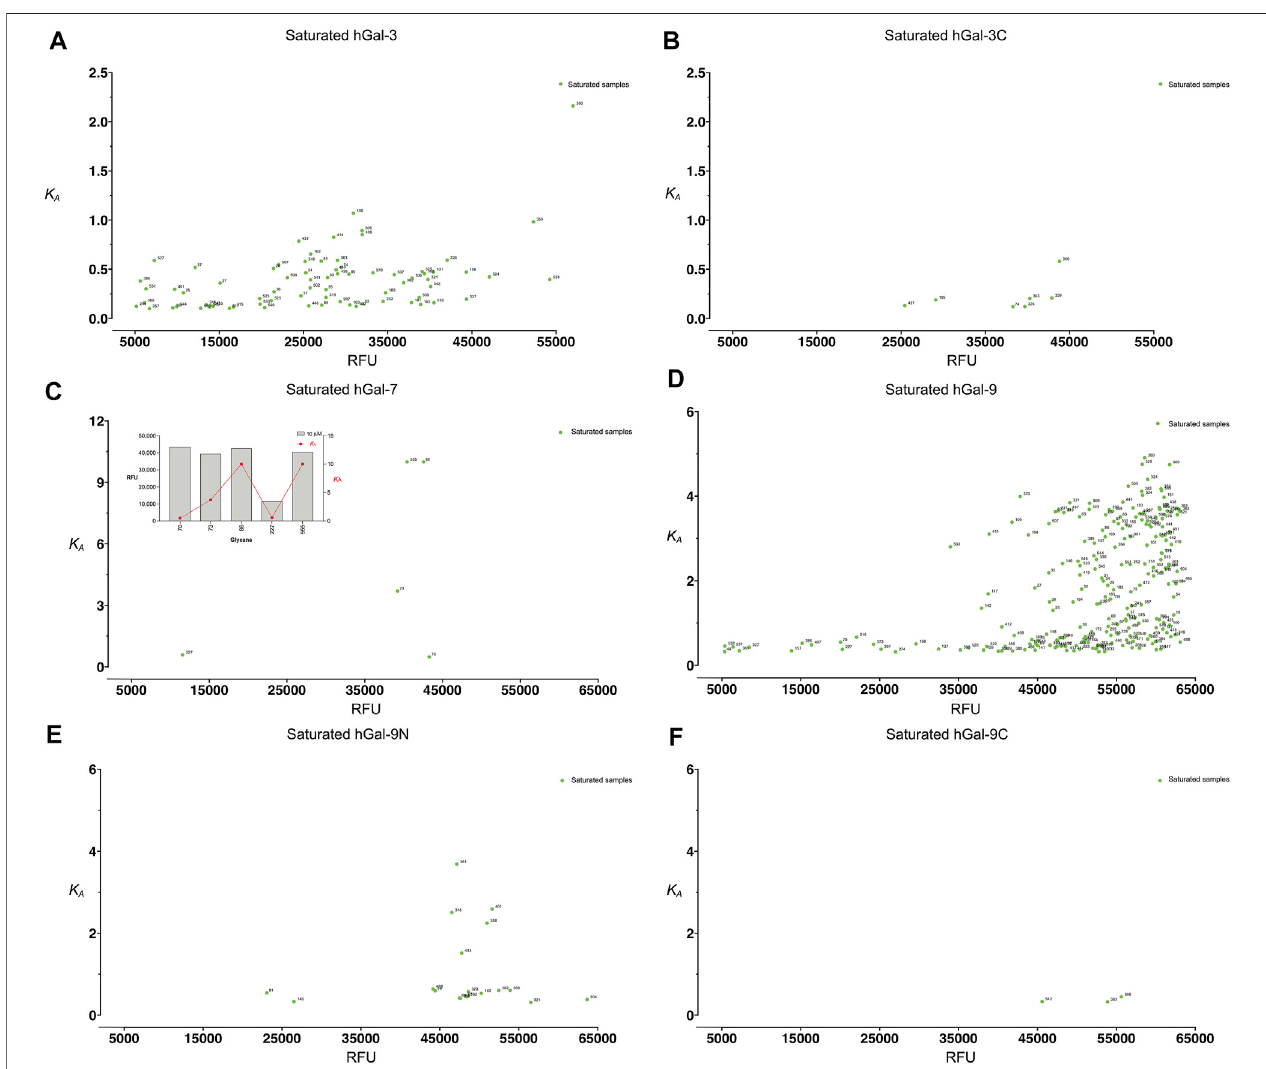
FIGURE 3 | Examination of the distribution of saturated glycans for each galectin . (A) The saturated samples ’ RFU values are plotted against K A for Gal-3. (B) The saturatedsamples ’ RFUvaluesareplottedagainst K A forGal-3C (C) Thesaturatedsamples ’ RFUvaluesareplottedagainst K A forGal-7.Abarplotispresentedwiththe fi ve saturated samples along with their K ’ RFU values are plotted against K A and RFU values shown on the upper left. (D) The saturated samples A for Gal-9 (E) The saturated samples ’ RFU values are plotted against K A for Gal-9N. (F) The saturated samples ’ RFU values are plotted against K A for Gal-9C.